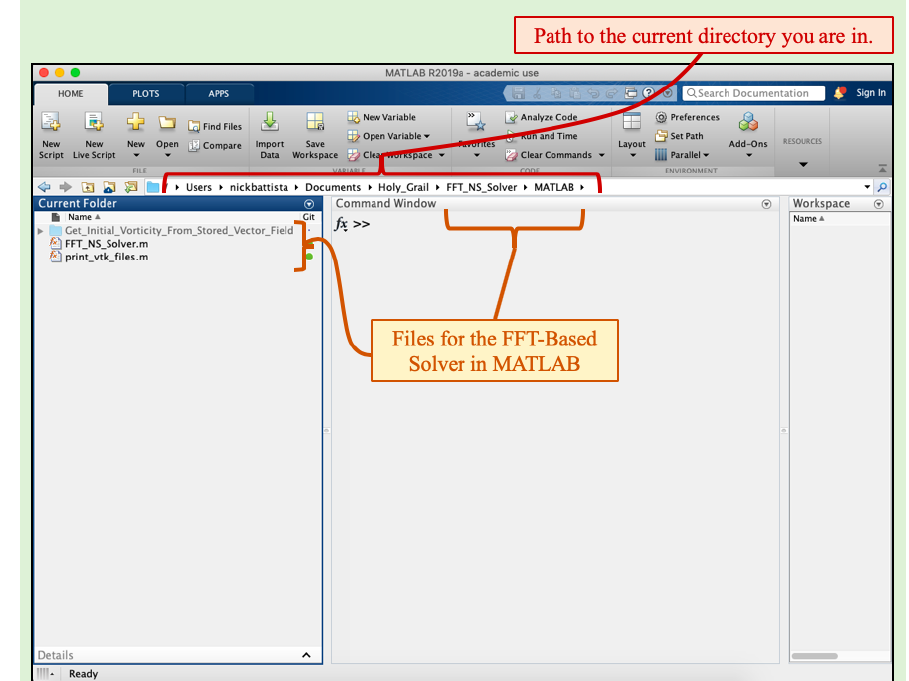
Figure 6. MATLAB GUI interface showing the path to the current directory folder for the MATLAB FFT-Based Spectral Solver as well as what files are contained within it.